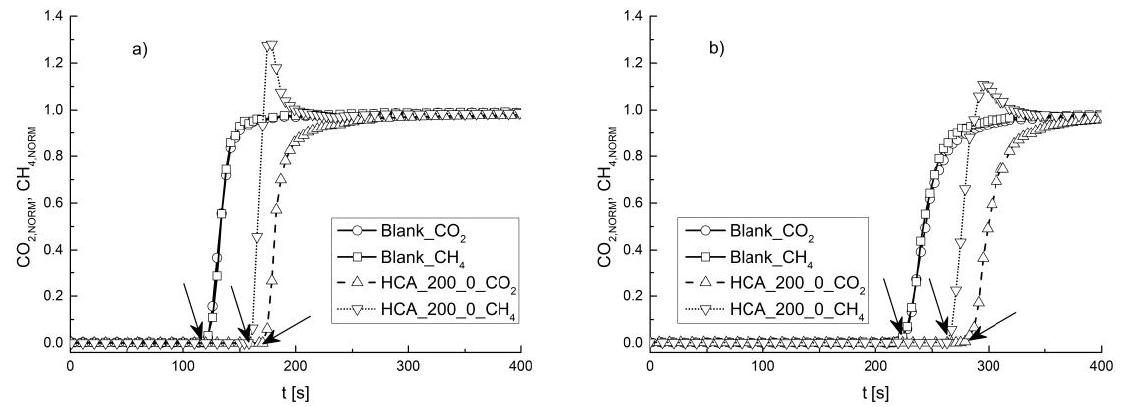
Figure 4. CO 2 / CH 4 adsorption curves at ( a ) 2 bar and ( b ) 5 Figure 4. CO 2 /CH 4 adsorption curves at ( a ) 2 bar and ( b ) 5 bar.